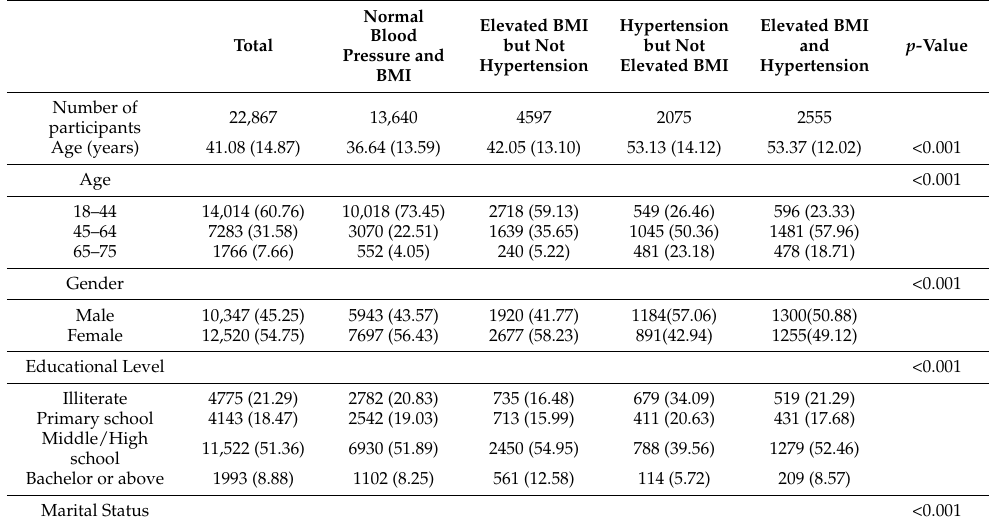
Table 2. Baseline characteristics of the study population on the presence of Chinese adults who have hypertension 1 , elevated BMI 2 or